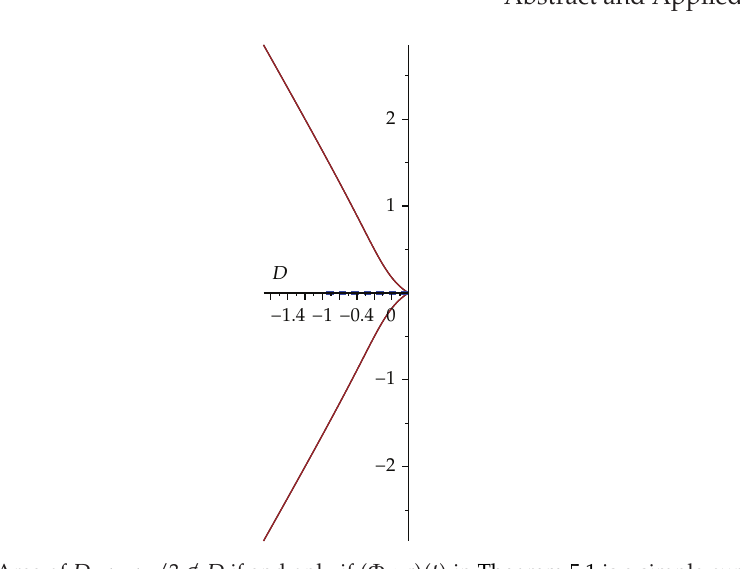
Figure 2: Area of D : w 0 w 1 / 3 / ∈ D if and only if (cid:2)Φ ◦ r (cid:3)(cid:2) t (cid:3) in Theorem 5.1 is a simple